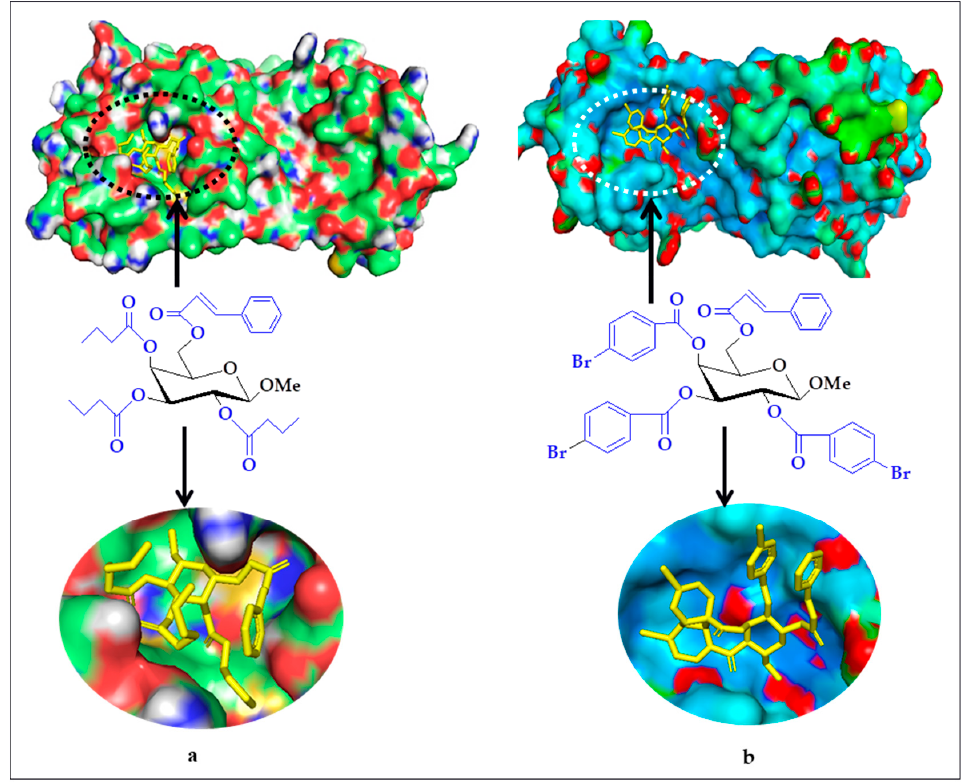
Figure 5. Docked conformation of analog ( 3 ) at inhibition bounding site of 6Y84 ( a ) and Docked conformation of analog ( 10 ) at inhibition bounding site of 6Y84 ( b ).